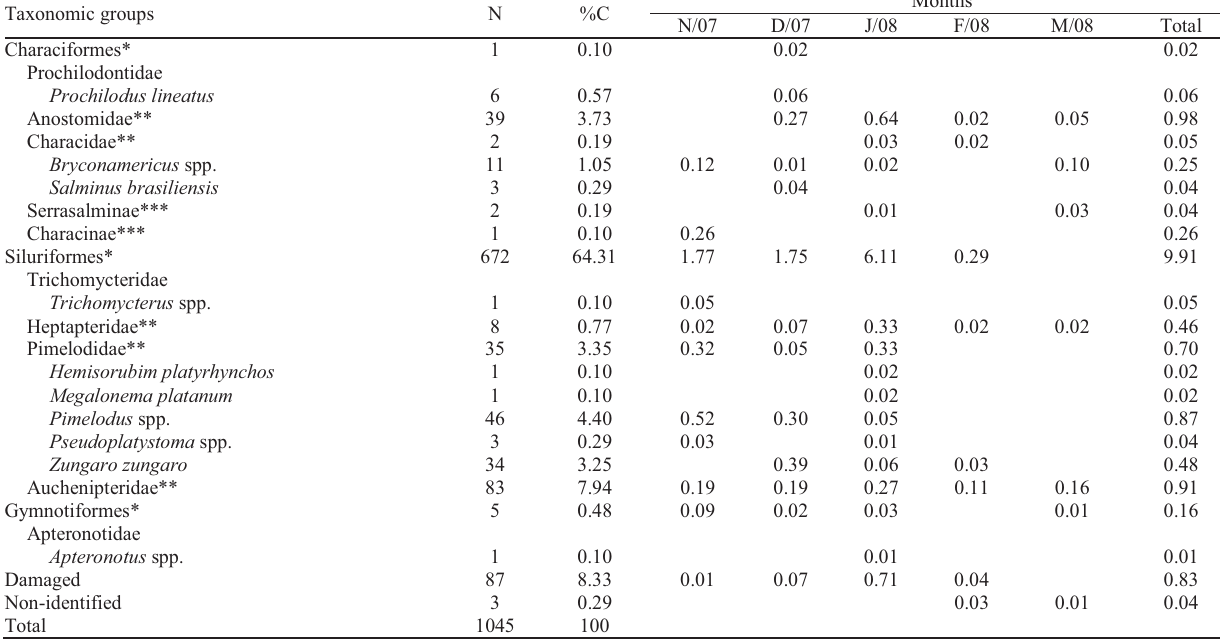
Table 1. Taxonomic groups of larvae (classification according to Reis et al ., 2003), with their respective total numbers of capture (N), percentage of capture; (%C) and mean density, collected in the headwaters of the Cuiabá River from November 2007 to March 2008. * = individuals identified only to the order level; ** = individuals identified only to the family level;*** = individuals identified only to the subfamily